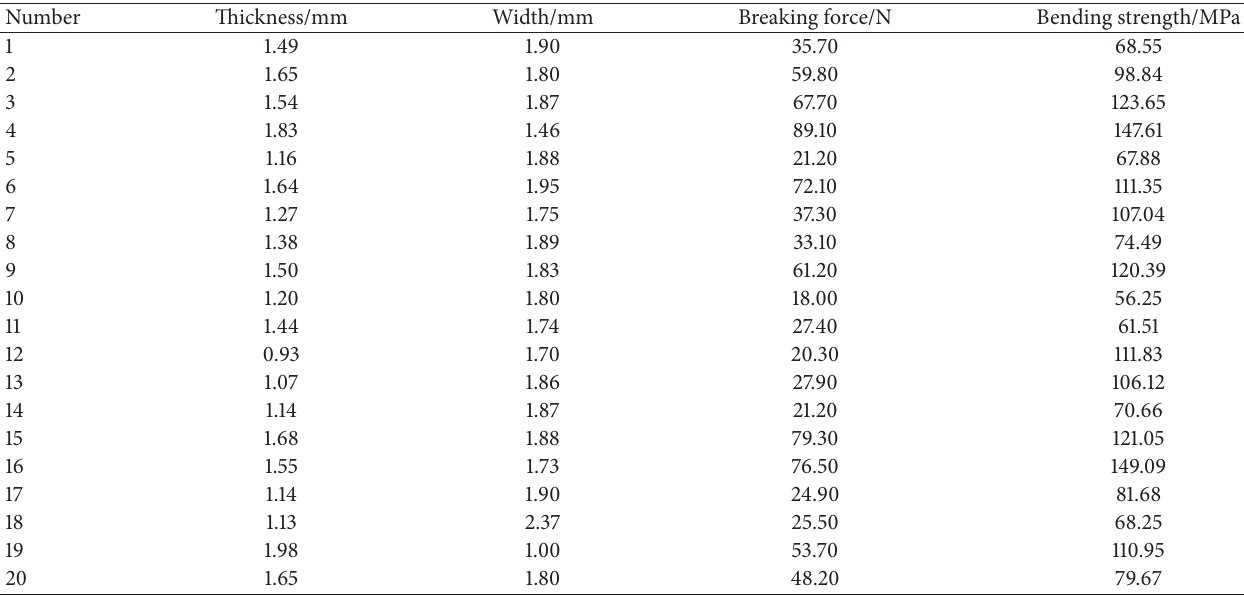
Table 2: Exact dimensions, breaking force, and bending strength of the Er,Cr:YSGG irradiated specimens (group 2). The mean value of the bending strength is 96.08 MPa with a standard deviation of 28.08 MPa.